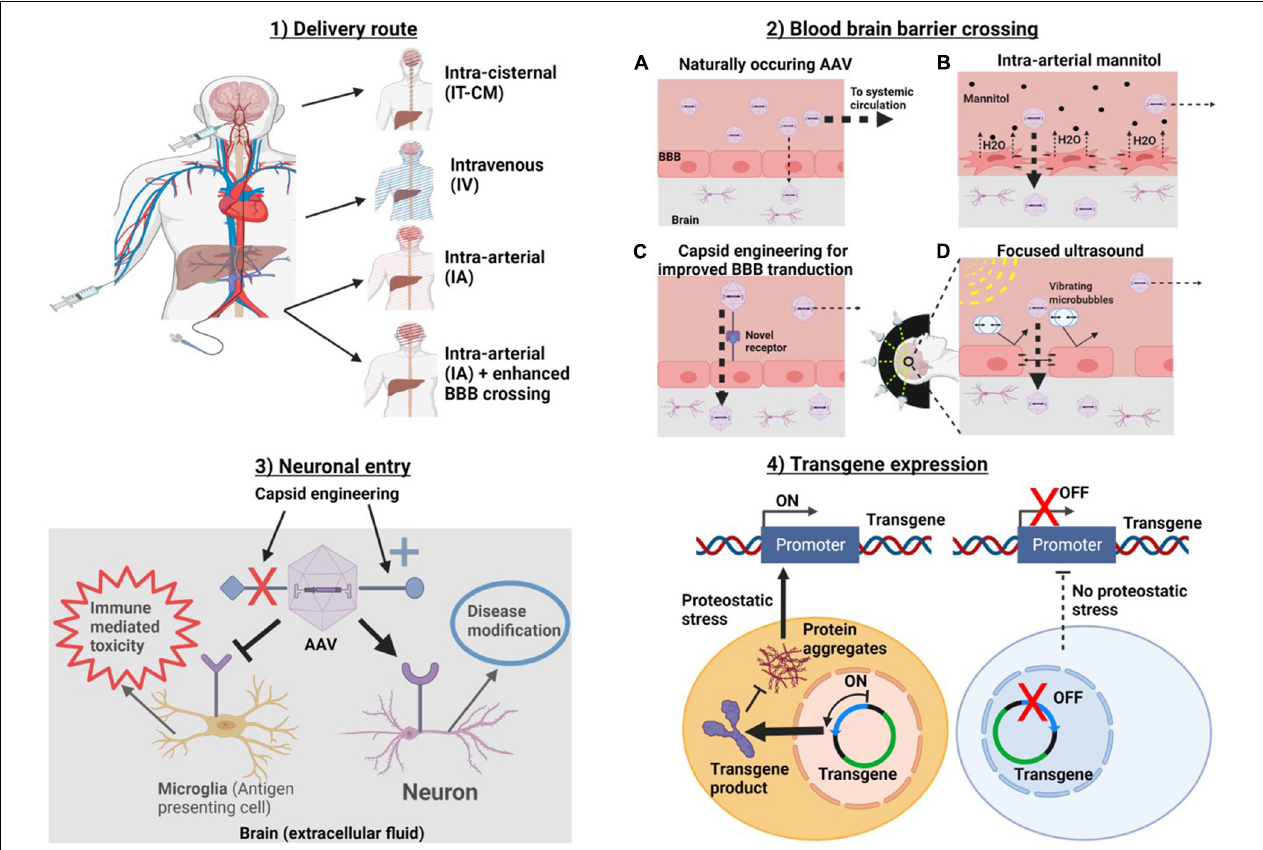
FIGURE 1 | Methods for optimizing at each of four stages of AAV delivery to the brain. In order to get to the brain AAVa are (1) introduced into the body via a delivery route. Routes which avoid systemic delivery such as IT-CM and IA with BBB crossing should be optimal. (2) If intravascularly delivered, a strategy for enhancing BBB delivery should be chosen. (3) Target cell entry (i.e., neurons for NDDs). This can be accomplished by capsid engineering to enhance specific cellular tropism. And (4) transgene expression. Promoters can be used to target transgene expression to specific cells and/or conditions, in this example, a promoter which drives gene expression in the context of proteostatic stress is used. This should reduce transgene toxicity. Created with